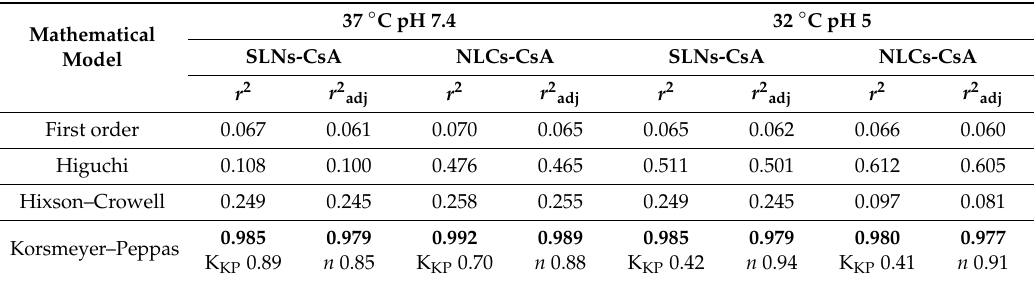
Figure 4. In vitro drug release study. Drug release from CsA-loaded SLNs ( A ) and CsA-loaded NLCs ( B ) under physiological (pH 7.4, 37 °C) and skin-mimetic conditions (pH 5.5, 32 °C) in 20% (v/v) ethanol ( n = 3; ** p < 0.01, *** p < 0.001, for differences between pH 5.5 and pH 7.4). Table 3. Estimated parameters, r 2 and r 2 adj , of the mathematical models fitted for CsA release from lipid nanoparticles.